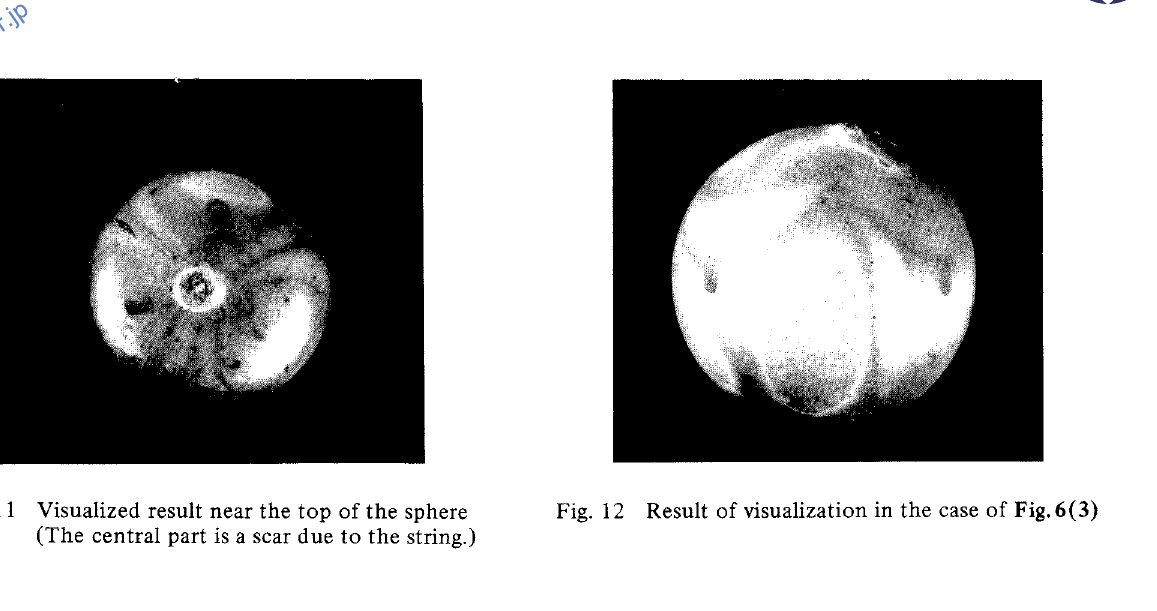
Fig. 12 Result of visualization in the case of Fig.